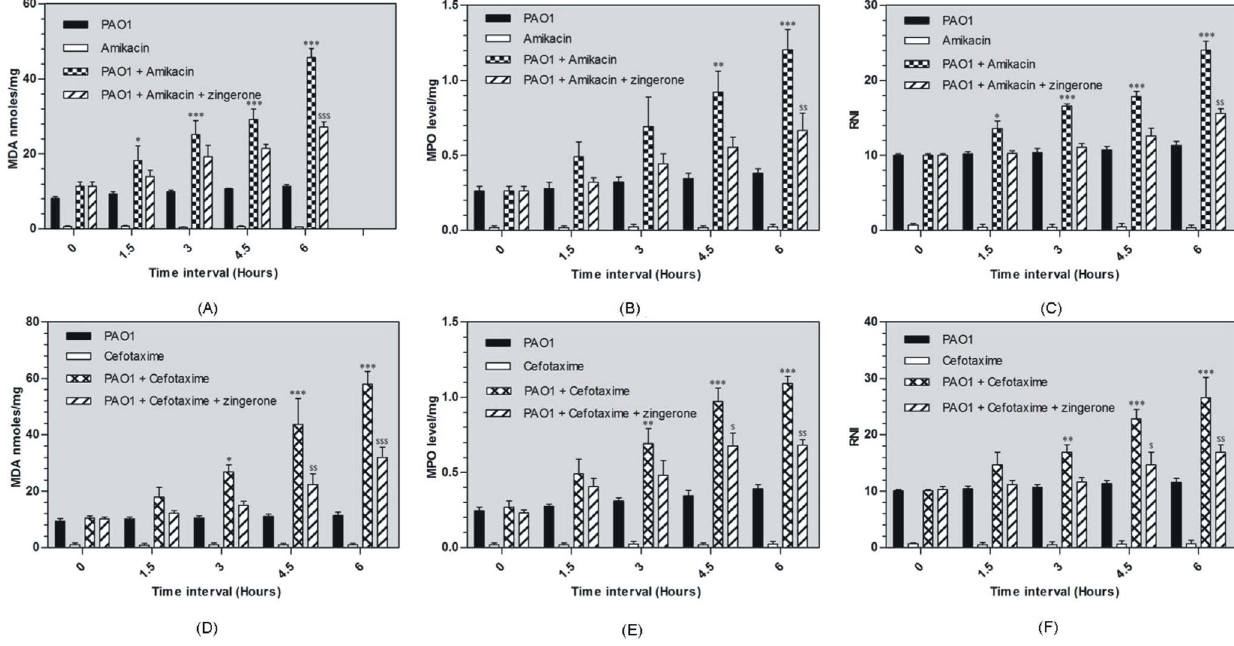
Figure 4. Effect of zingerone treatment on hepatic MDA/RNI/MPO production in liver homogenate against antibiotic mediated endotoxemia (amikacin Fig.4-A, B, C) and cefotaxime (Fig 4-D, E, E) ( $ , * p , 0.01, $$ , ** p , 0.01 and ***, $$$$$$ p , 0.001).